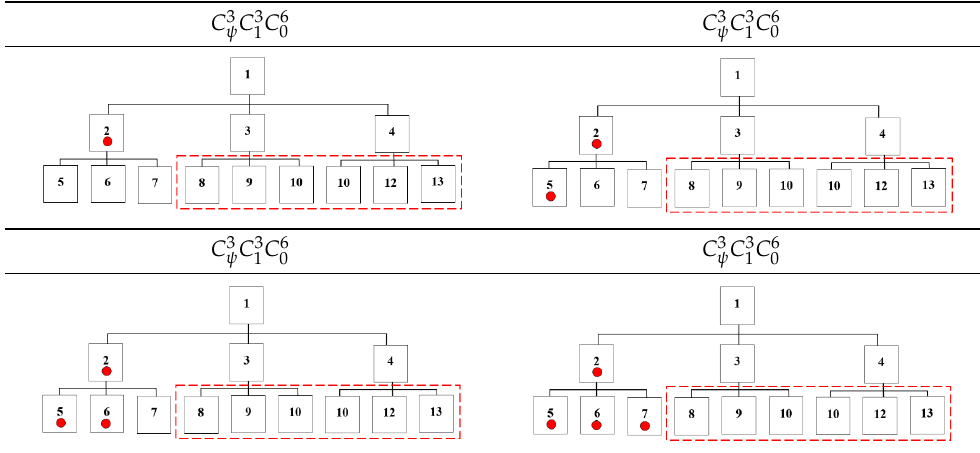
Table 1. Combinations of the 2nd and 3rd levesl for absorptions at the 1st node of the 2nd level.